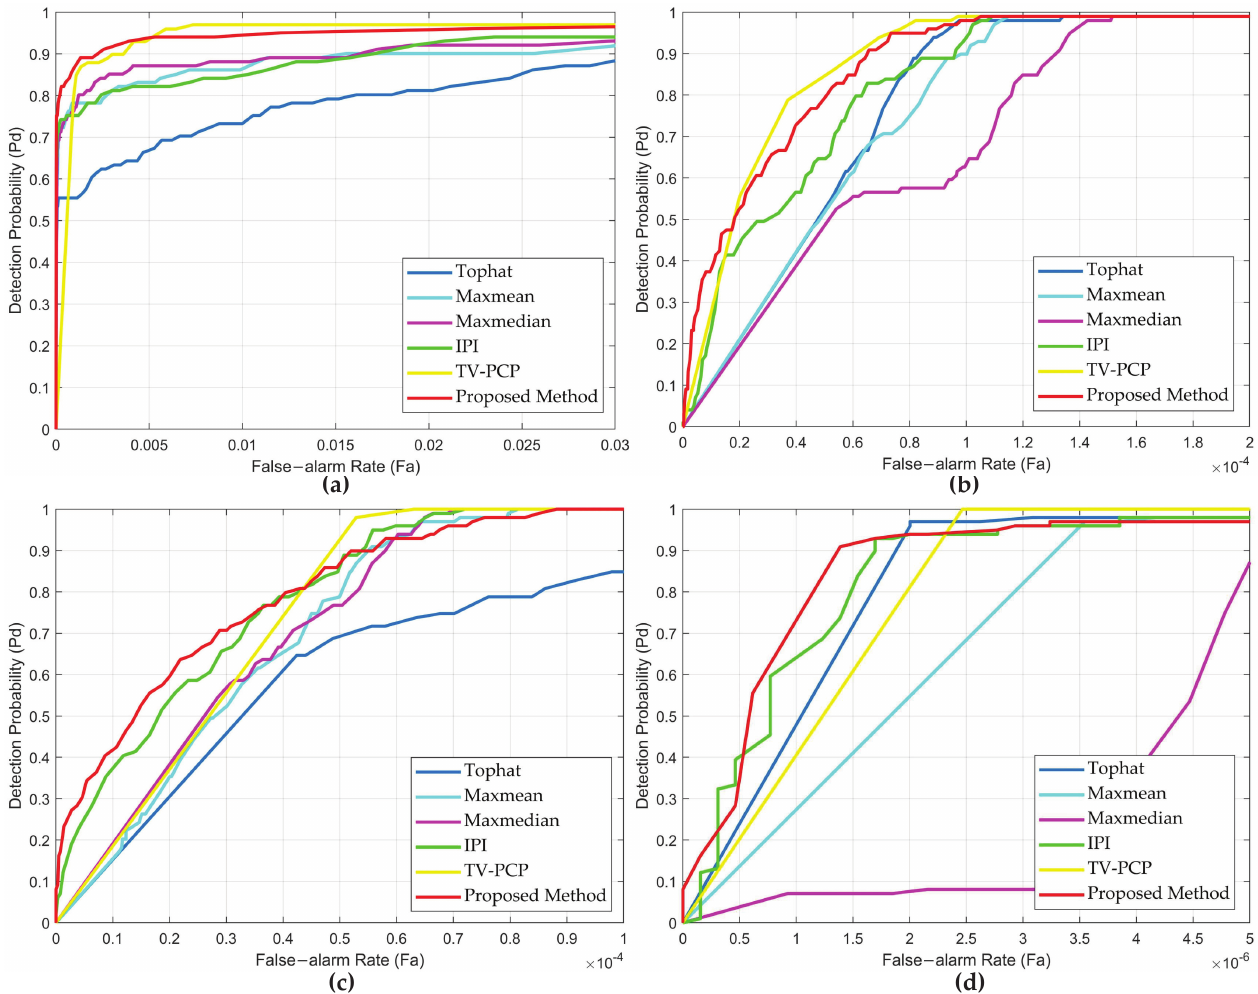
Figure 8. The receiver operating characteristic (ROC) curves of different methods for four real image sequences. ( a ) Sequence 1. ( b ) Sequence 2. ( c ) Sequence 3. ( d ) Sequence